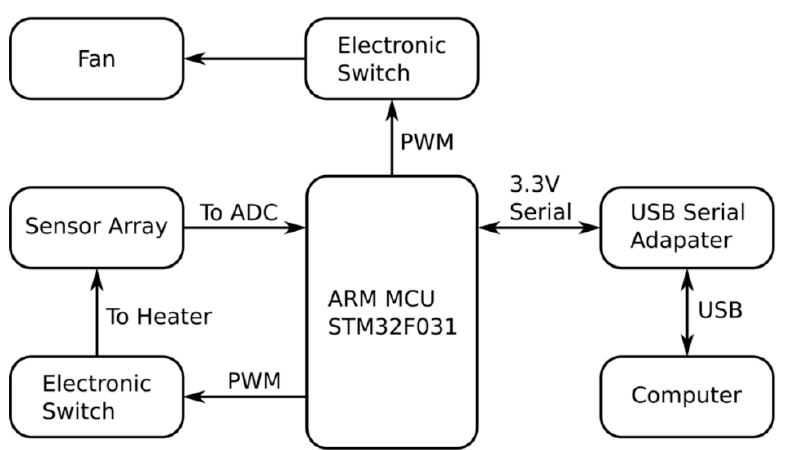
Figure 2. Functional block diagram of the e-nose. STM32F031 was used as the microcontroller unit that controls the fan and the heater by pulse width modulation (PWM). The 12-bit ADC receives the senso- array readings and transfers the data to the Raspberry Pi4 via a USB serial adapter.